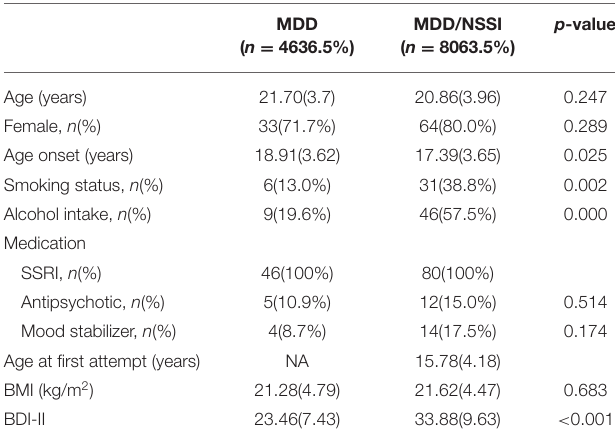
TABLE 1 | Demographic and clinical characteristics of MDD patients with and without